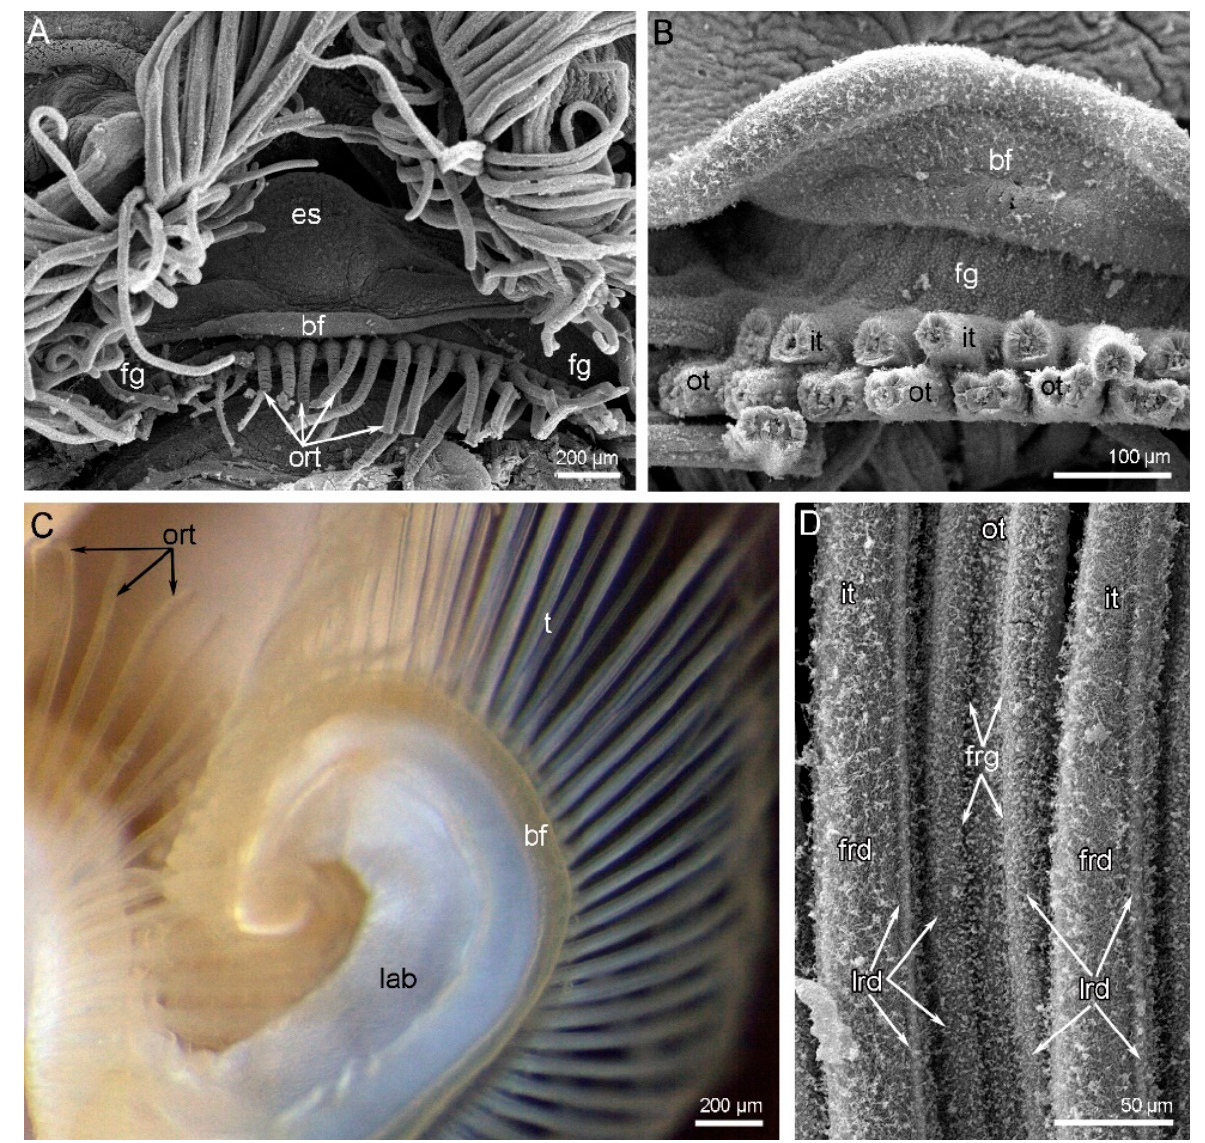
Figure 2. Details of the lophophore organization in Novocrania anomala adults. ( A ) The oral part of the lophophore; SEM. ( B ) A portion of the brachial arm: the brachial fold and double row of tenta- cles are visible; SEM. ( C ) The base of the lophophore arm, viewed from the ventral side; photograph of a live lophophore. ( D ) Fine morphology of tentacles: one outer and two inner tentacles are visible; SEM. Abbreviations: bf—brachial fold; es—esophagus; fg—food groove; frd—frontal ridge; frg—frontal groove; it—inner tentacle; lab—lophophore arm base; lrd—lateral ridge; ort—oral tentacles; ot—outer tentacle; t—tentacle.